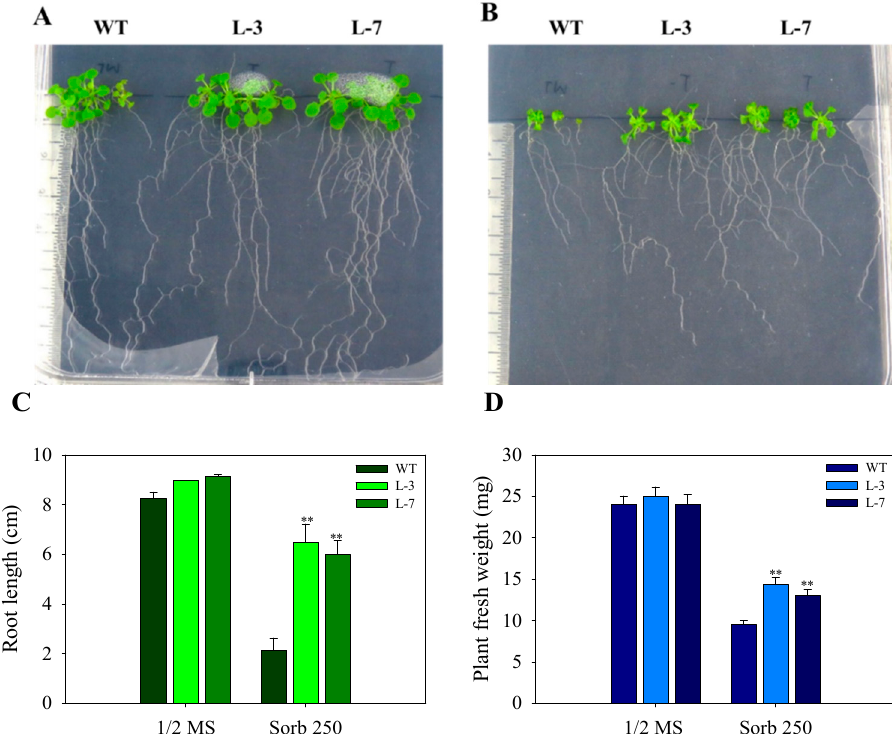
Figure 5. Effect of osmotic stress on the growth of WT and AnnAt8 expressing Arabidopsis plants. ( A , B ) Root and shoot growth of plants under normal (half strength MS) and osmotic stress (sorbitol 250 mM), respectively. In each case, the observations were made on day 28 after germination. Three replicates were used per treatment, and the experiment was repeated thrice; ( C ) Root length of WT and transgenic lines L-3 and L-7 under normal and osmotic stress conditions; ( D ) Fresh weight of WT and transgenic lines under normal and osmotic stress conditions. For root length and fresh weight data, observations were made on day 28 and for each replicate (n) the average values for 15 plants of WT and transgenic lines were taken. Data represent means of n = 3 ± SE. Two asterisks indicate that the mean values of transgenic lines were significantly higher than that of WT (control) when analyzed by one-way ANOVA ( p < 0.01).